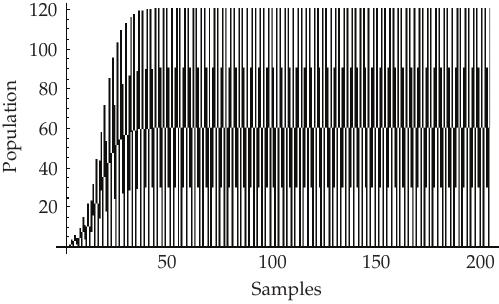
Figure 2: μ (cid:8) 2 , K (cid:8) 200 , d (cid:8) 0 , p (cid:8) 0 . 01 , α (cid:8) 0 . 001 , and γ (cid:8) 0 .